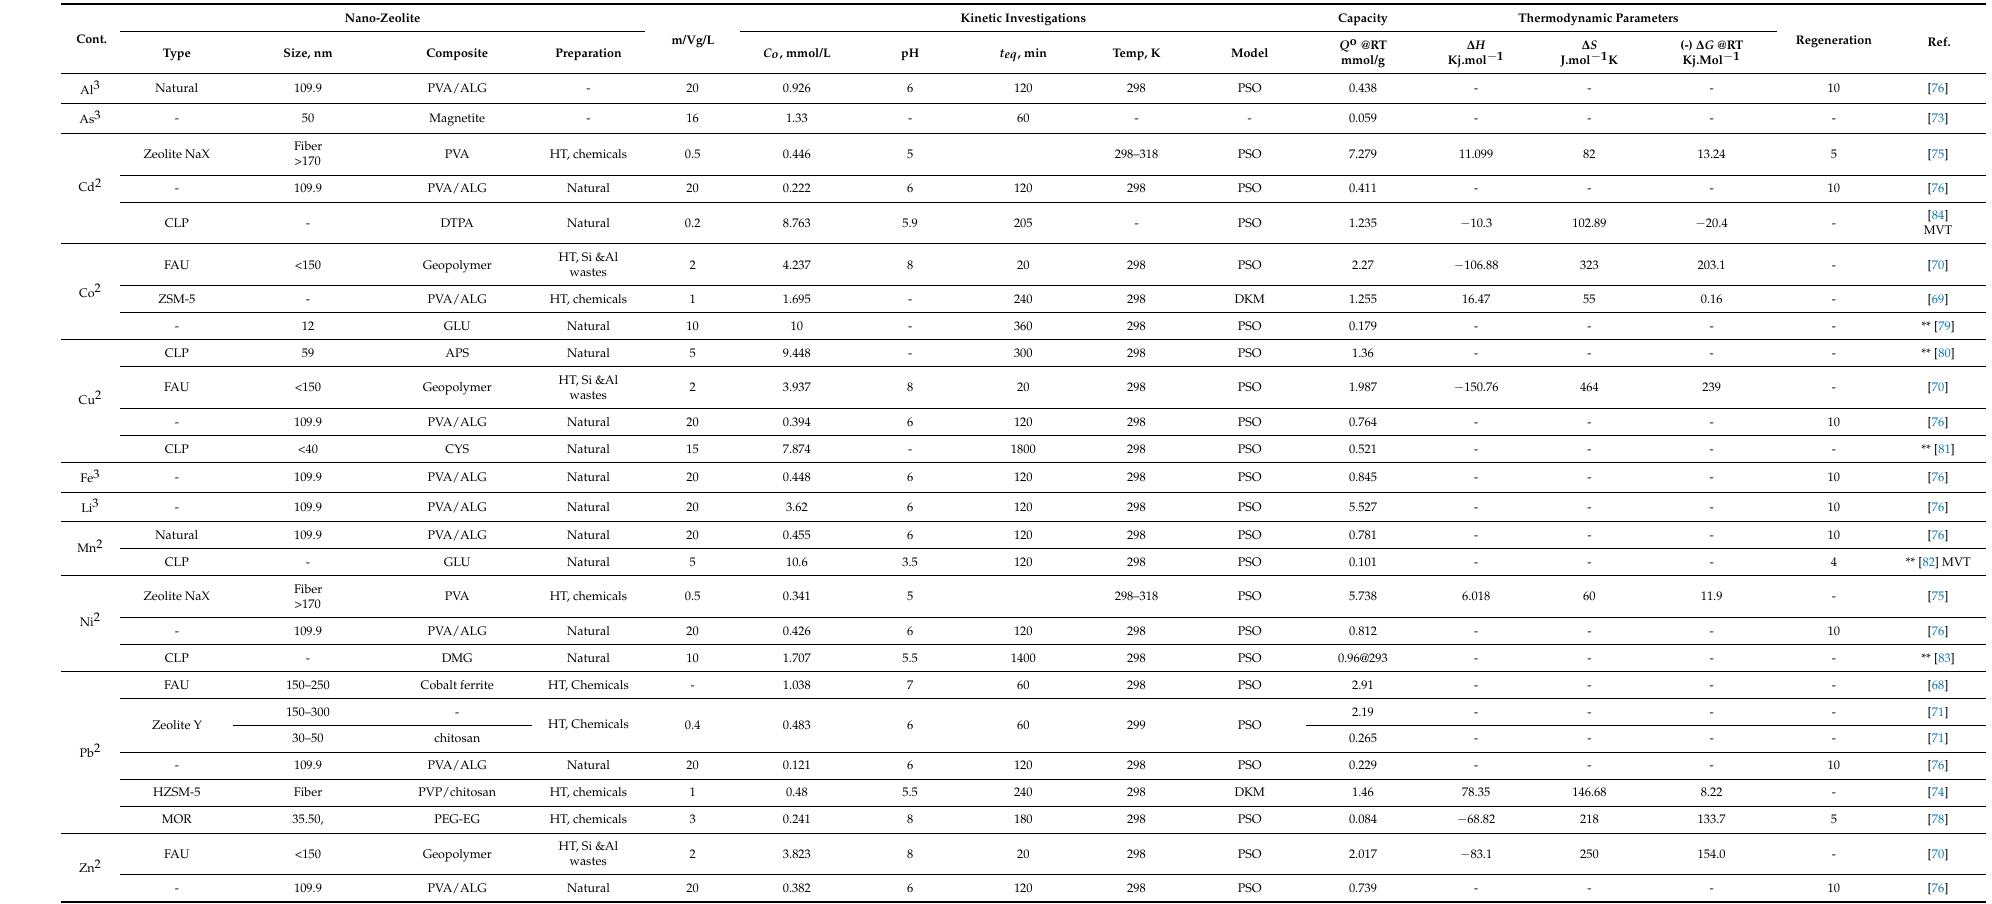
Table 5. Investigations of nano-zeolite in cation removal form single contaminant